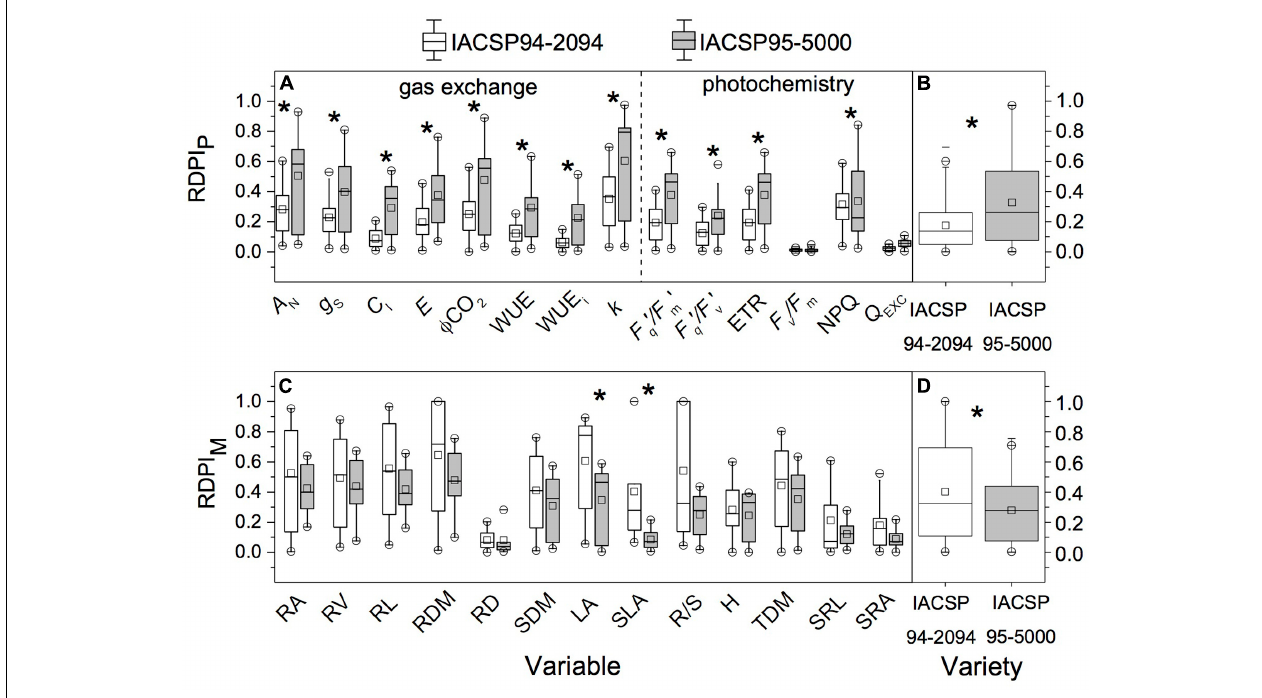
FIGURE 7 | Individual (for each trait, in A,C ) and overall (average of all traits, in B,D ) relative distance plasticity index considering physiological (RDPI P ) and morphological (RDPI M ) traits in sugarcane varieties IACSP94-2094 and IACSP95-5000 subjected to varying water availability. ∗ means significant difference between varieties ( p < 0.05, Mann–Whitney’s test). A N , leaf CO 2 assimilation; g S , stomatal conductance; C I , intercellular CO 2 partial pressure; E , transpiration; φ CO 2 , CO 2 fixation efficiency; WUE, actual photosynthetic water use efficiency; WUE i , intrinsic photosynthetic water use efficiency; k , instantaneous carboxylation efficiency; F q (cid:48) / F m (cid:48) , operating efficiency of photosystem II; F q (cid:48) / F v (cid:48) , photochemical quenching; ETR, apparent electron transport rate; F v / F m , potential quantum efficiency of photosystem II; NPQ, non-photochemical quenching; Q EXC , relative excess of light energy; RA, root area; RV, root volume; RL, root length; RDM, root dry mass; RD, root diameter; SDM, shoot dry mass; LA, leaf area; SLA, specific leaf area; R/S, root:shoot ratio; H , height; TDM, total dry mass; SRL, specific root length; SRA, specific root